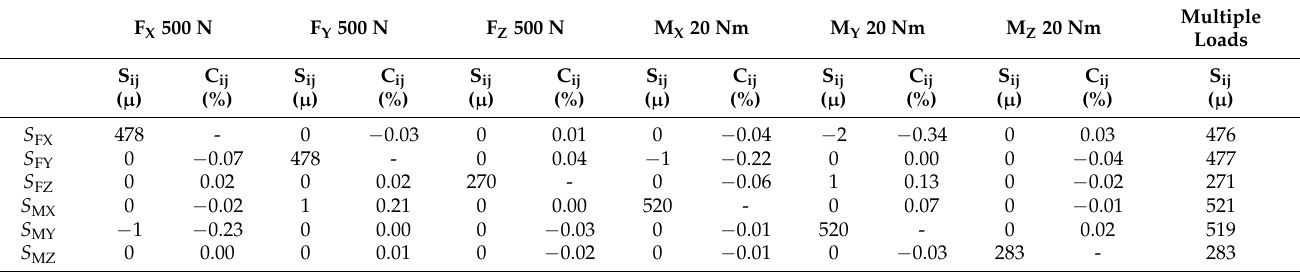
Table 6. Crosstalk from finite element analysis of 32 strain gage